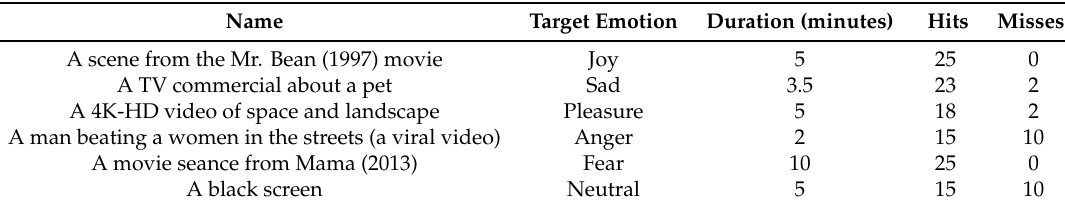
Table 1. Videos and subjective results.